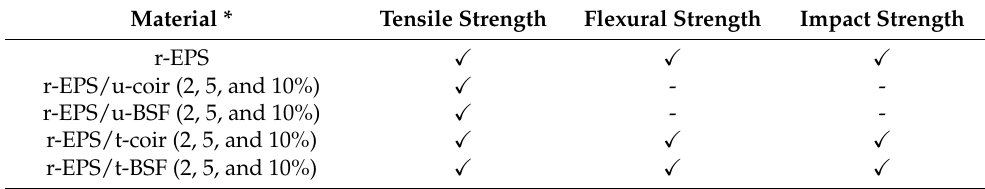
Table 1. Materials prepared from recycled EPS to evaluate the mechanical properties. Material * Tensile Strength